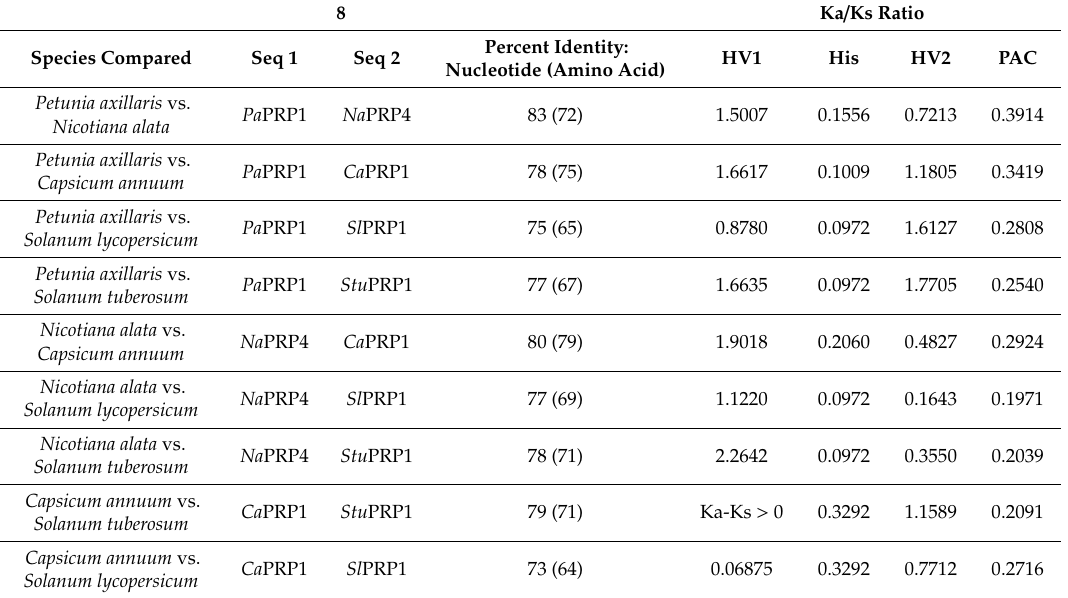
Figure 8. Contractions and expansions of XKPP motifs are the most striking feature of divergence in HD-AGP sequences from five divergent genera of the Solanaceae. The figure shows multiple alignments of HD-AGP protein sequences with manual adjustments of gaps in MEGA. The sequences are from five divergent species within the Solanaceae: P. axillaris ( Paa PRP1), Nicotiana alata ( Na PRP4), Capsicum annuum ( Ca PRP1), Solanum lycopersicum ( Sl PRP1), and Solanum tuberosum ( Stu PRP1). The signal peptide sequence is shown with a dotted line above; the two hypervariable domains, HVI and HV2, are boxed in red; a black line lies over the histidine-rich domain; the highly conserved PAC/Ole-1 domain is highlighted in blue. Analysis of mutation rate via Ka/Ks ratios was far more informative for these phylogenetically diverse taxa than it was for sister species within a genus (see Table 3). Ka/Ks ratios were calculated for pairwise comparisons of the five HD-AGP orthologs using the DnaSP program. The Ka/Ks ratios Table 7. Summary of Ka / Ks ratios between pairwise comparisons of domains in HD-AGPs from five confirm purifying selection in the signal peptide, histidine-rich domain and PAC domains (Table 7). genera in the Solanaceae. Positive selection is indicated in bold type. In the one case where the value of Ks equaled zero, and the Ka value was greater than zero, the result is written as “Ka-Ks > 0” to signify that all the substitutions in that domain were non-synonymous. The signature of positive selection is seen in all the pairwise comparison except in the comparisons of Capsicum annuum and S. lycopersicum HD-AGPs (last